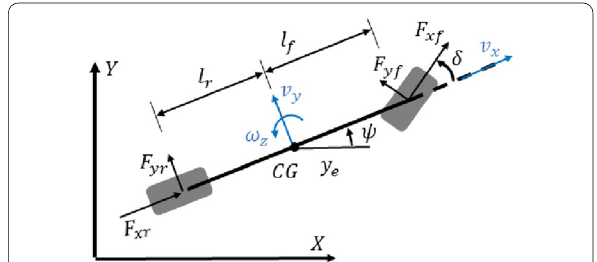
Figure 4 Vehicle dynamic